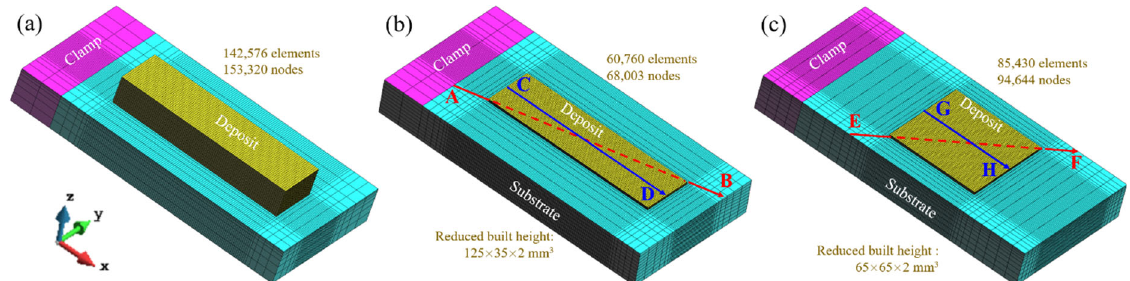
Figure 2. FE mesh models: ( a ) 40-layer rectangular block; ( b ) 4-layer rectangular block; ( c ) 4-layer square block. The lines AB and EF at the build-substrate interface are used to analyze the residual stresses while the lines CD and GH at the deposit top are used to analyze the displacement of DED parts.